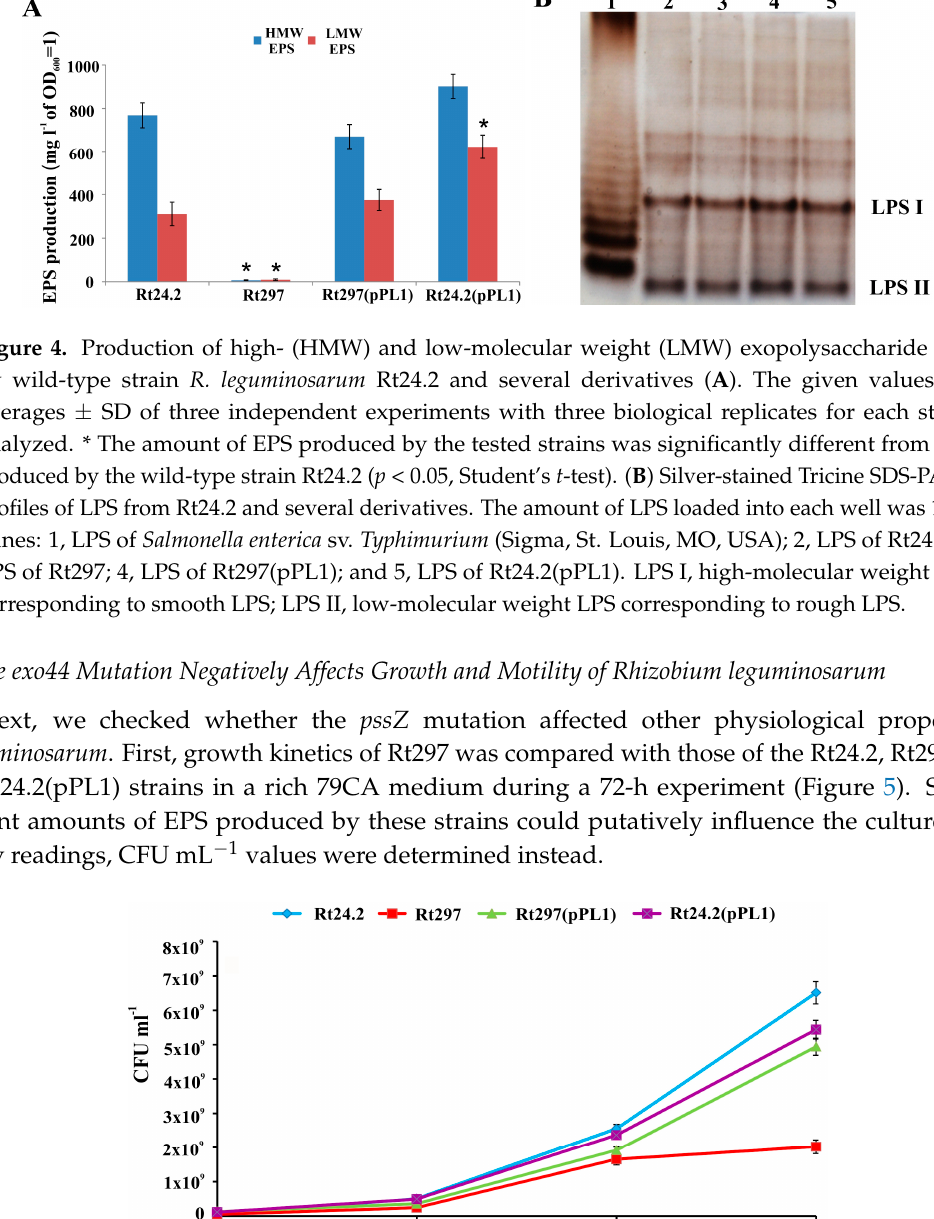
Figure 5. Growth kinetics of the wild-type strain R. leguminosarum Rt24.2 and its derivatives in 79CA medium. The given values are averages ± SD of two independent experiments with three biological replicates for each strain analyzed.